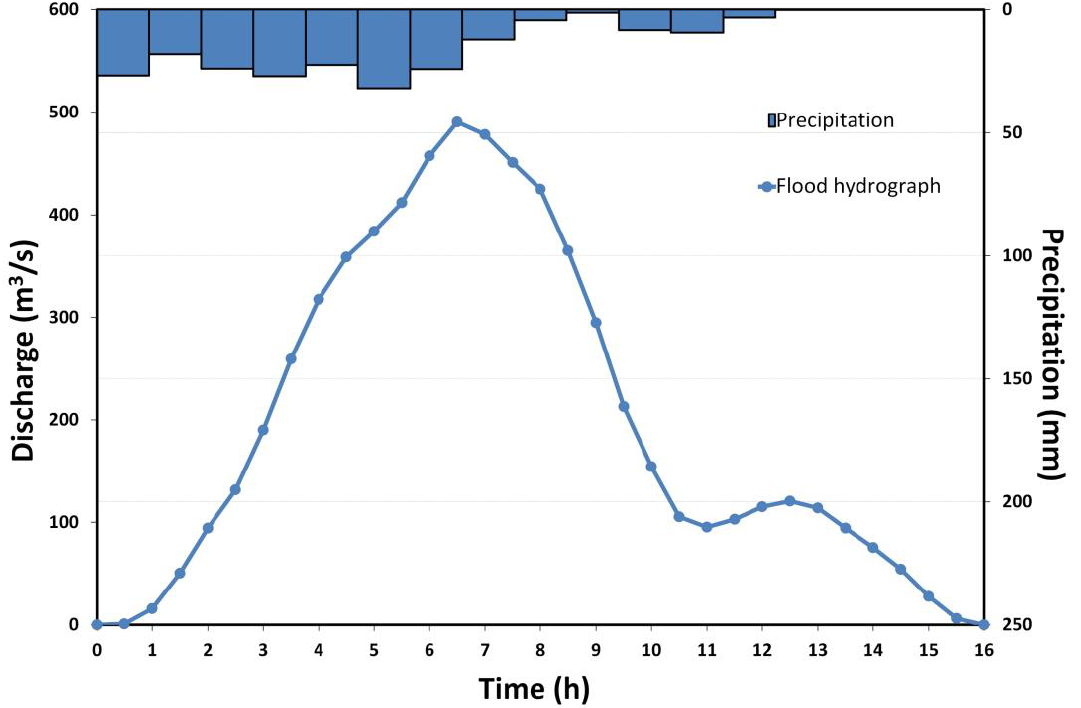
Figure 4. The rainfall hyetograph of the 9 October 2006 and the estimated flood hydrograph of the event by applying the Clark Instantaneous Unit Hydrograph (CIUH) method (Adapted from [27]).